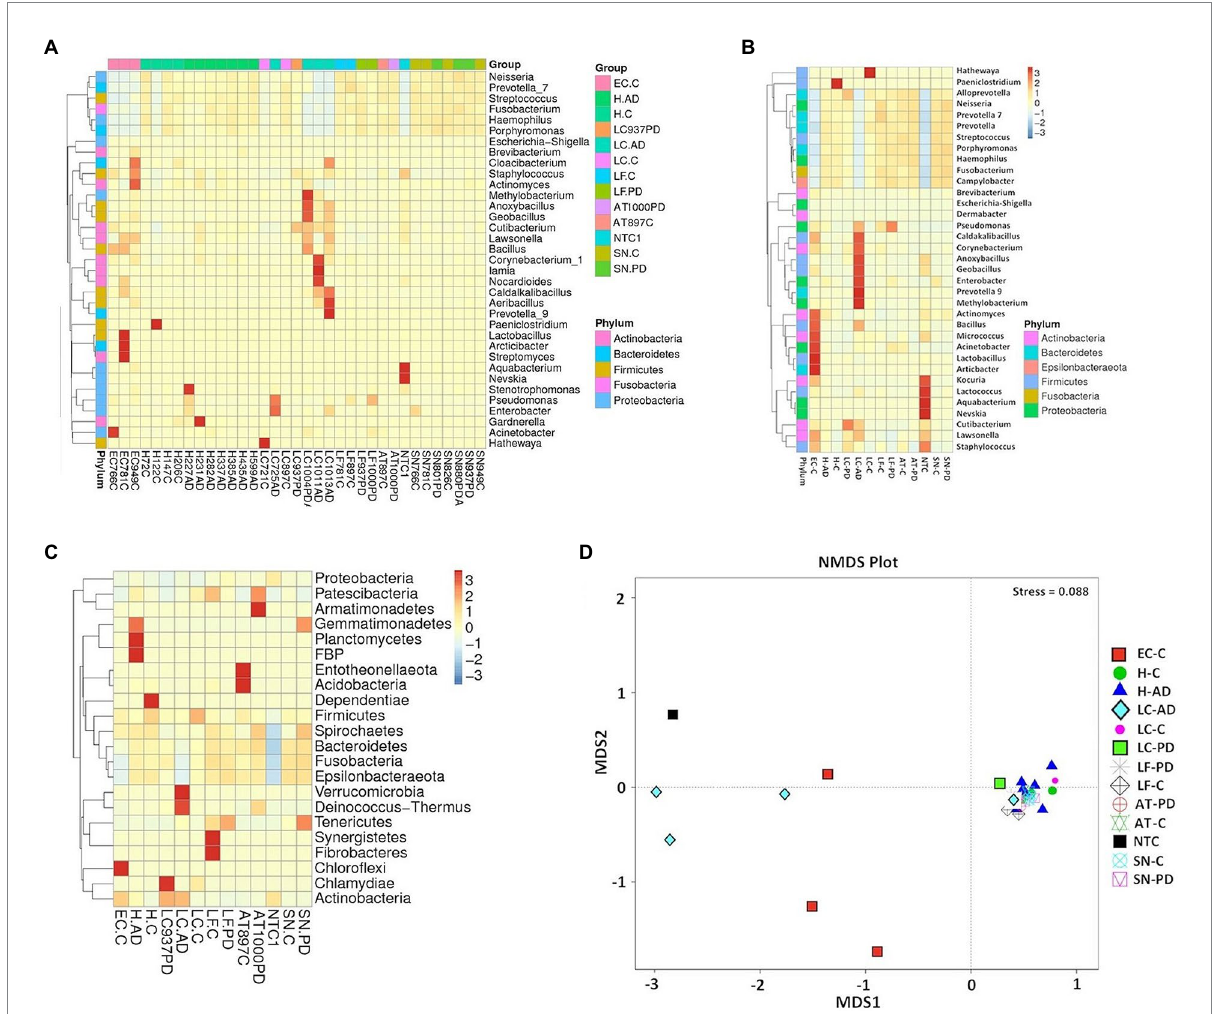
FIGURE 3 Analysis of bacterial population characteristics based on relative abundance of OTUs taxonomically classified using 97% OTU clustering. (A) heatmap cluster analysis (genus) individual sample, (B) heatmap cluster analysis (genus) group, (C) heatmap cluster analysis (phylum) group, (D) Group analysis by Non-Metric multi-Dimensional Scaling (NMDS). Abbreviations: AD – Alzheimer’s disease, C – control, PD – Parkinson’s disease; AT - anterior temporal cortex (BA38); EC - entorhinal cortex (BA34); H - hippocampus; LC - locus coeruleus; LF - lower pre-frontal cortex (BA11); NTC - No template Control; SN – substantia